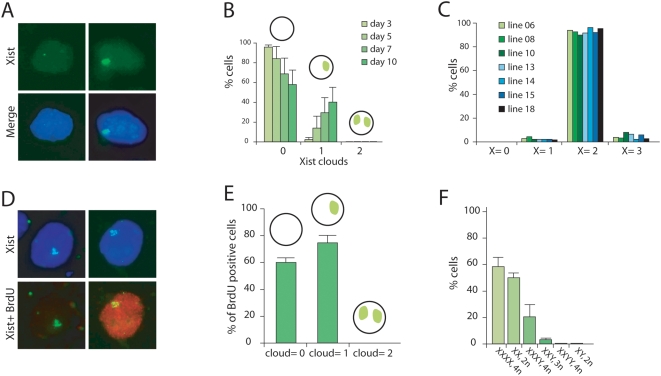
Analysis of XCI in differentiating triploid XXY ES cells.A) RNA FISH analysis with an Xist probe (FITC, DNA in blue) on day 3 differentiated triploid ES cells, shows cells with no (left panels) or one (right panels) Xist cloud. B) The average distribution and standard deviation of cells with different numbers of Xist clouds throughout differentiation. C) DNA FISH analysis on day 7 differentiated triploid ES cells. Shown is the relative number of cells with 0, 1, 2 and 3 X chromosomes. D) Combined Xist RNA-BrdU detection (Xist in FITC, BrdU in Rhodamine red, DNA in DAPI blue), indicating the presence of cells with negative and positive BrdU staining (from left to right). E) Quantification of the Xist RNA-BrdU detection, shown are the relative number and standard deviation of BrdU positive cells with 0, 1 and 2 Xist clouds. F) The relative number and standard deviation of cells that have initiated XCI (at least one Xi), per cell line at day 3 of differentiation.